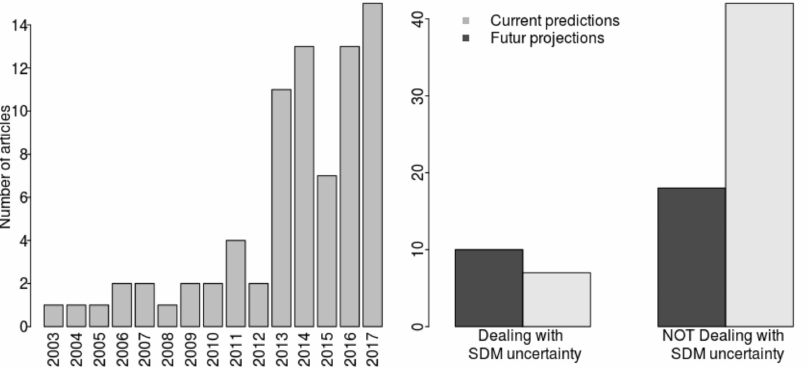
Figure A1. Results of the analysis of 76 publications generating conservation priorities, based on the distribution patterns of species: on the left, the number of publications per year. On the right, the number of publications according to whether or not they take into account the uncertainties related to modeling methods, for current and future